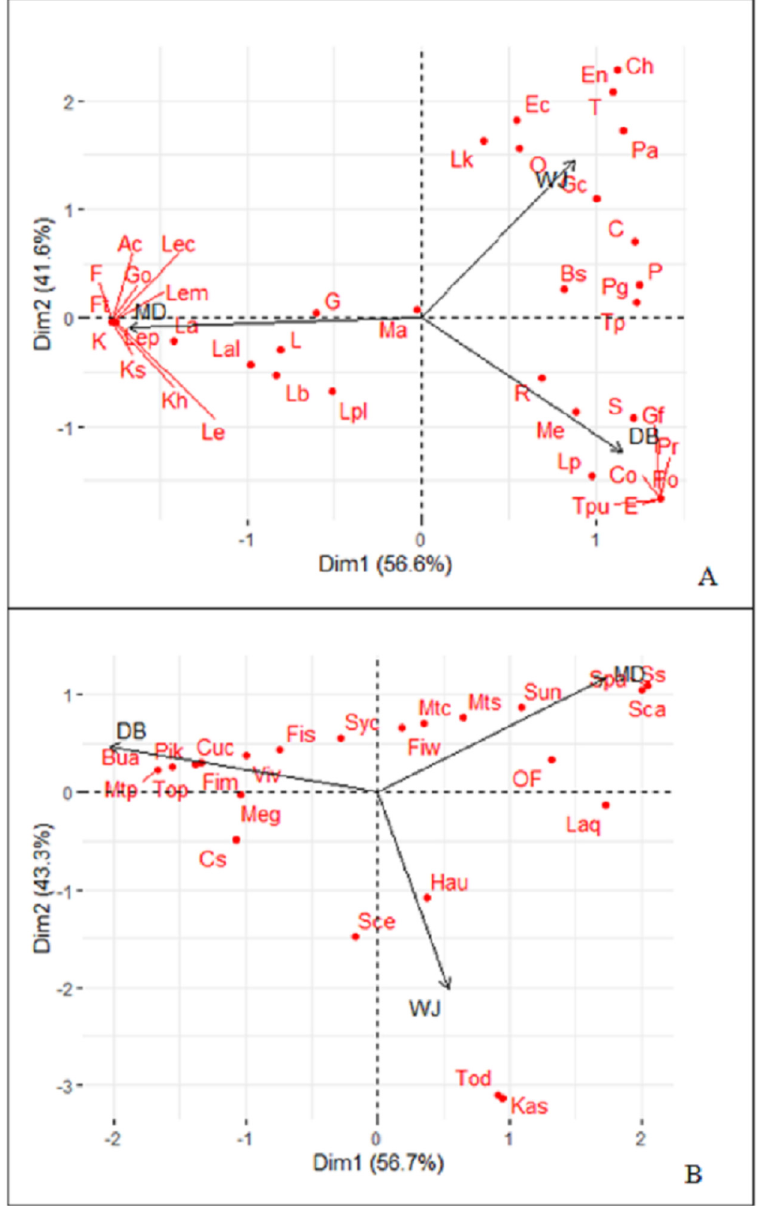
Figure 2. tb-PCA biplots of bacterial ( A ) and yeast ( B ) communities typical for DB, MD, and WJ wines. Abbreviations ( A ) F- Fructobacillus sp., Ft- Fructobacilus tropaeoli , Ac- Acetobacter cerevisiae , Go- Gluconobacter oxydans , Lec- Leuconostoc citreum , Lem- Leuconostoc mesenteroides , Lep- Leuconostoc pseu-